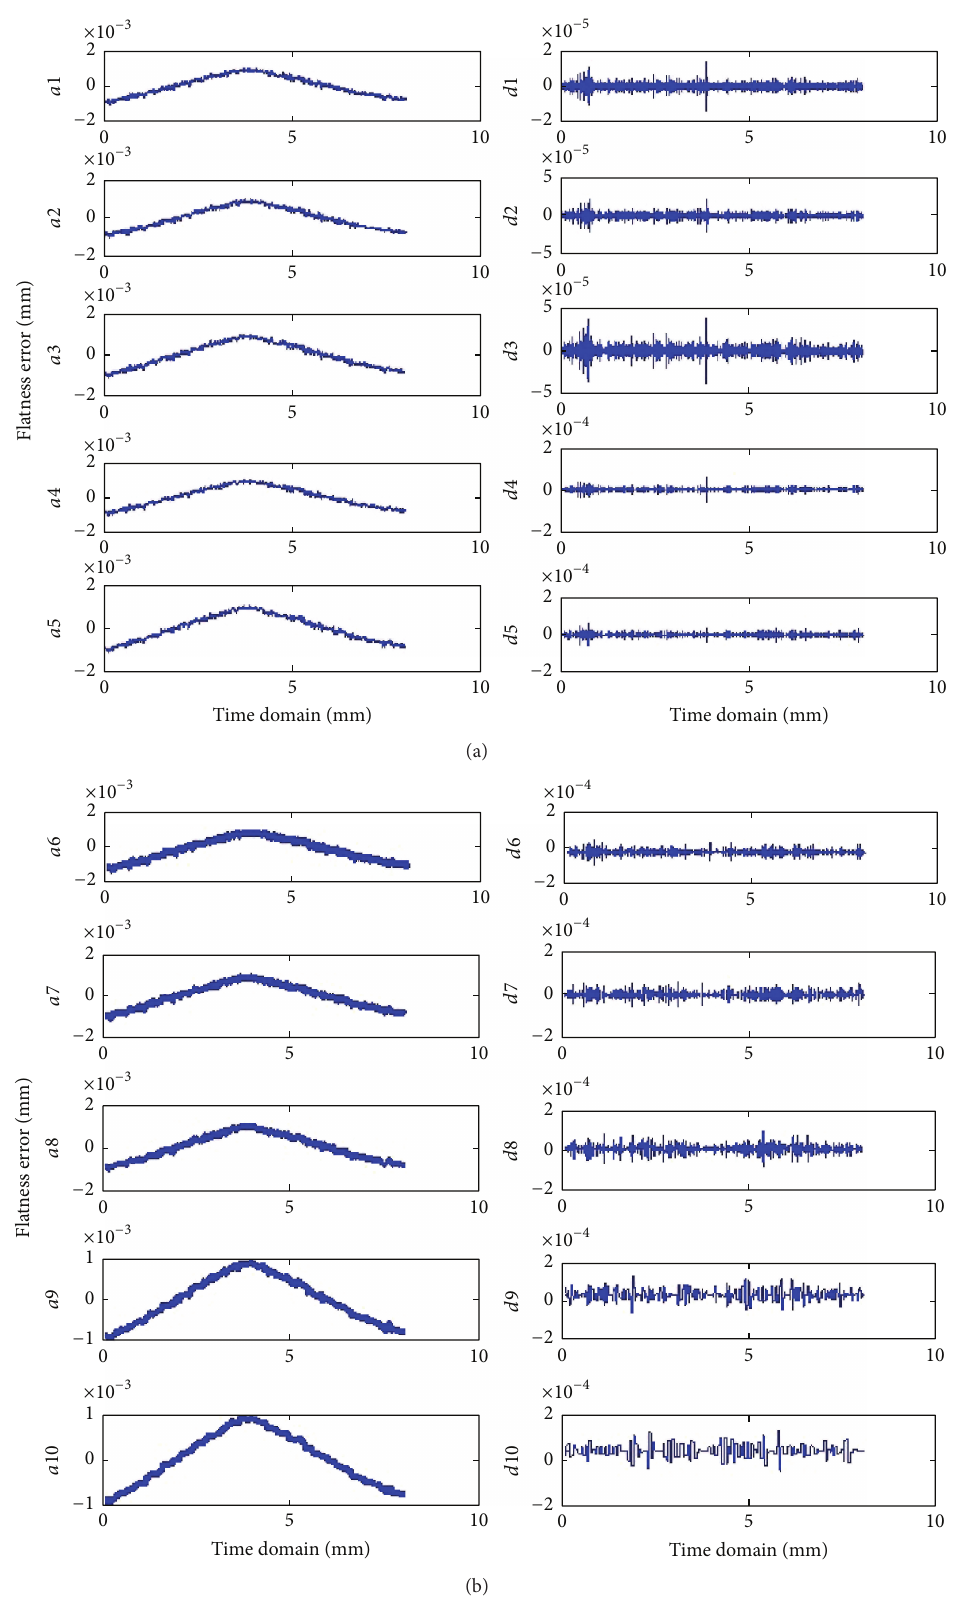
Figure 3: Processed result in ten